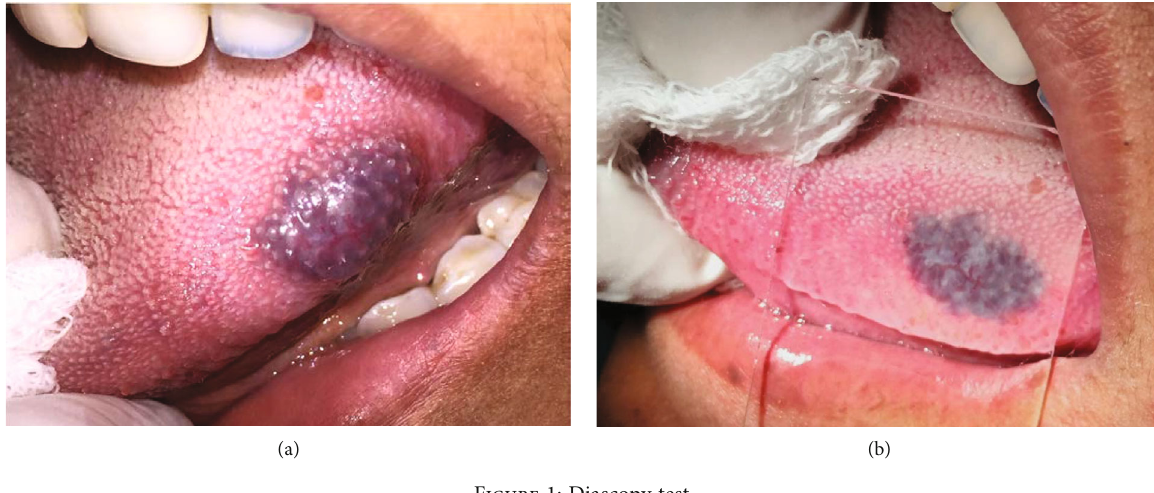
Figure 1: Diascopy